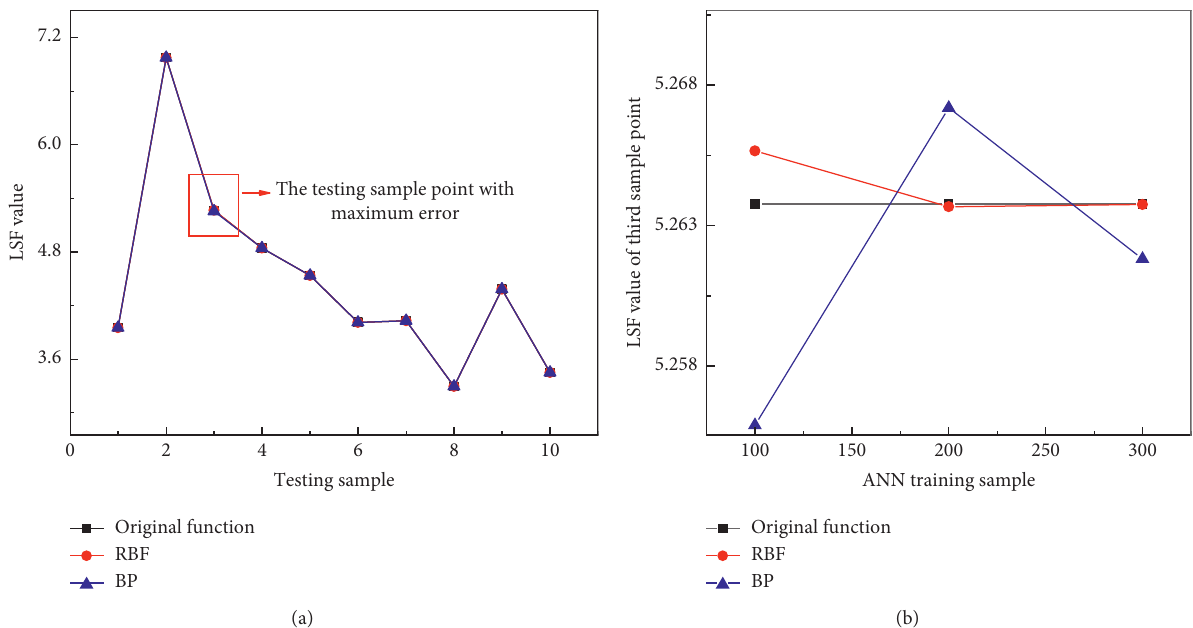
Figure 4: Comparison between the original LSF values and the predicted LSF values by ANNs. (a) The LSF value at testing sample for an ANN sample size of 100. (b) The LSF value of the third testing sample point relative to change in the ANN sample data size.